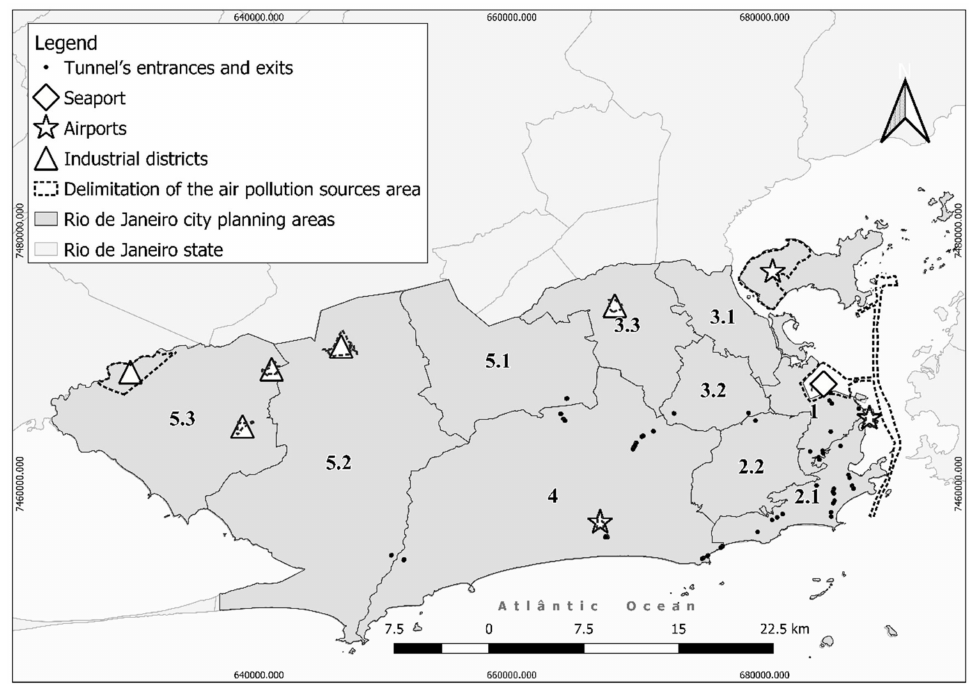
Figure 1. Spatial location of potential air pollution sources and delimitation of planning areas, the city of Rio de Janeiro,